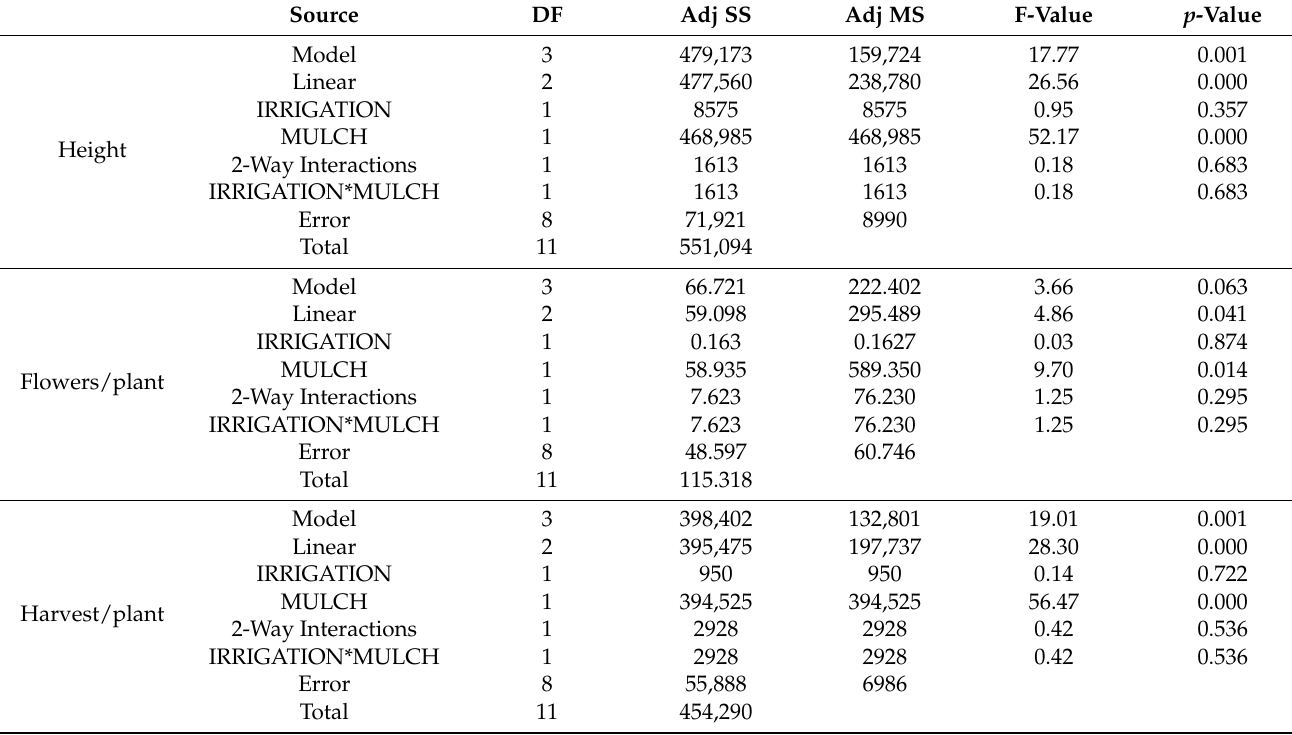
Table 4. Analysis of variance for factor and regression interactions of height, flowers/plant and har- vest/plant.